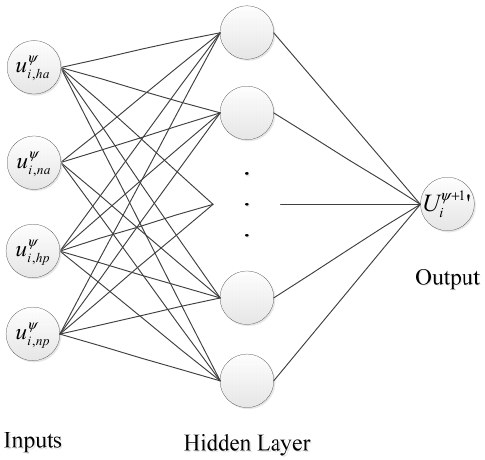
Figure 4. Intelligent transportation system based on the proposed methods.